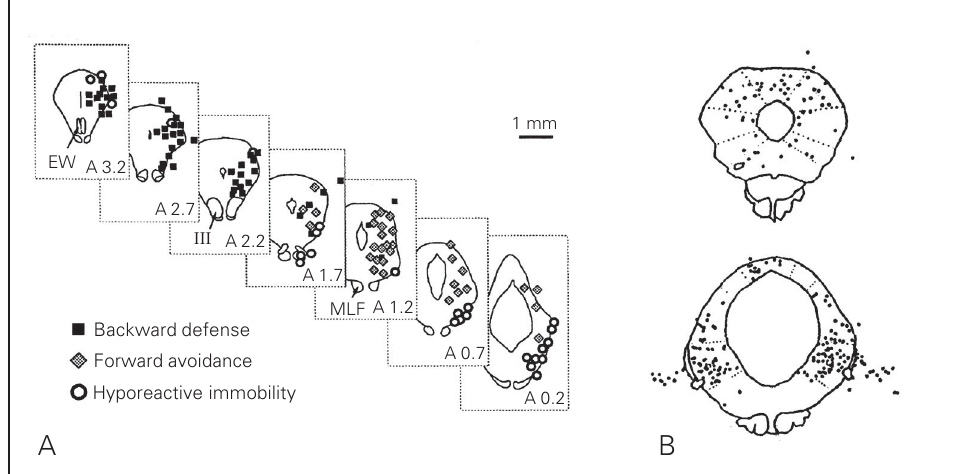
Figure 1. Functional studies. A , Sites of excitatory amino acid mi- croinjections into the periaque- ductal gray and behavioral reac- tions thus elicited in the freely moving rat. B , Periaqueductal gray neurons showing condi- tioned fear-related Fos expres- sion. III, oculomotor nucleus; EW, Edinger-Westphal nucleus; MLF, medial longitudinal fascicu- lus. Reprinted respectively from Carrive (8) and Carrive et al. (18), (cid:1) 1993, 1997, with permission of Elsevier